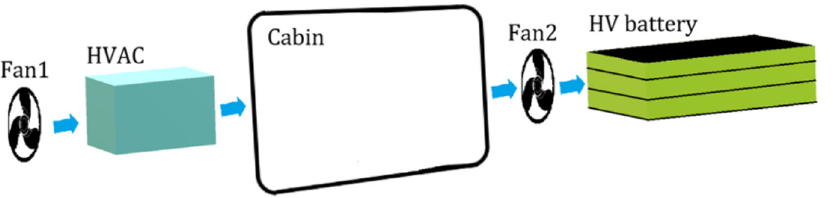
Figure 4. Schematic diagram of the cabin and battery air cooling system.